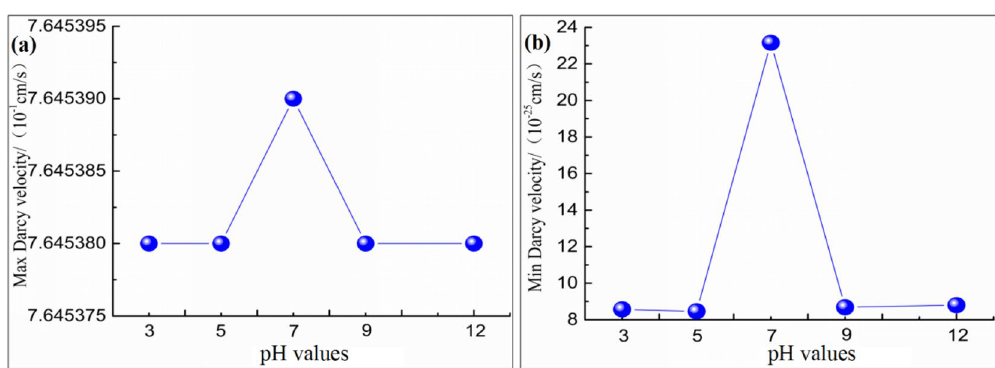
Figure 4. Changes in Darcys velocity with with the solution pH values. ( a ) Maximum velocity; ( b ) Minimum